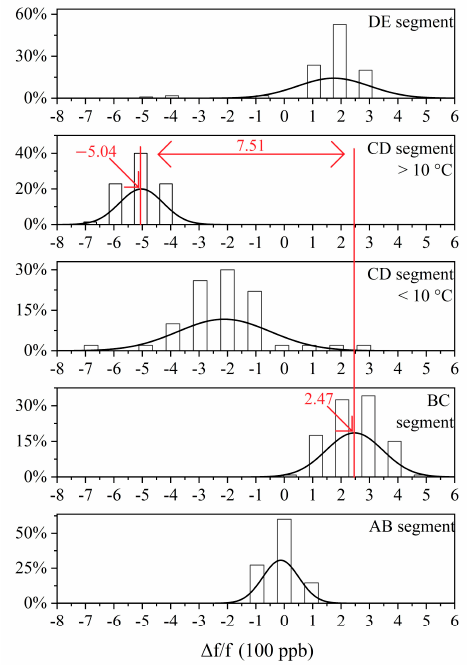
Figure 10. Frequency distribution diagram before hysteresis compensation.